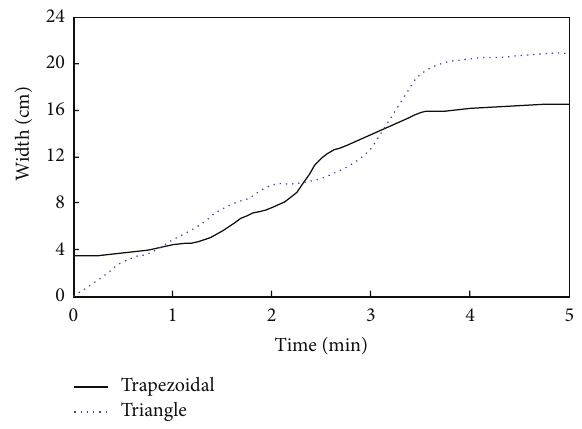
Figure 18: Evolution for the bottom width of different shapes of discharge